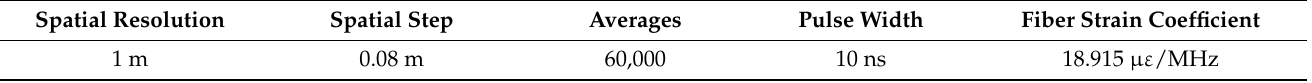
Table 1. Parameters used for BOTDA distributed strain measurements.